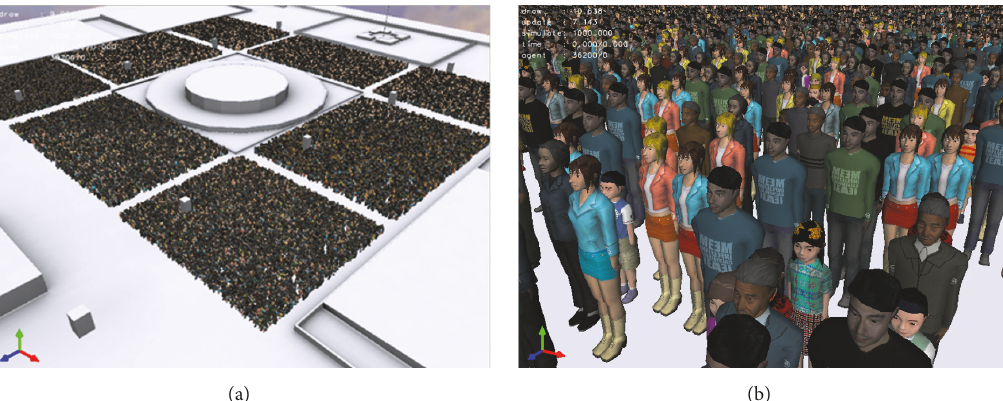
Figure 3: Our massive crowd simulation system. (a) The full view of the scene, the scene contains a total of 36200 individuals. (b) The local magnification of the scene.